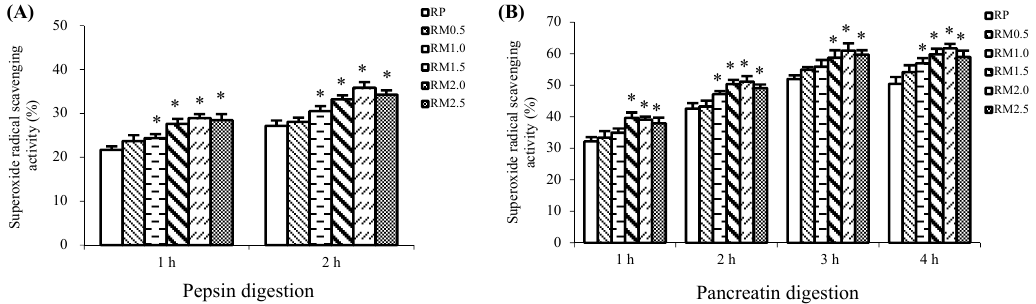
Figure 2. Superoxide radical scavenging activities of rice protein (RP) and methionine added to rice protein (RM) hydrolysates during in vitro digestion with pepsin ( A ) and pancreatin ( B ). Values are the means ± SEM ( n = 3). * p < 0.05, in comparison with RP.